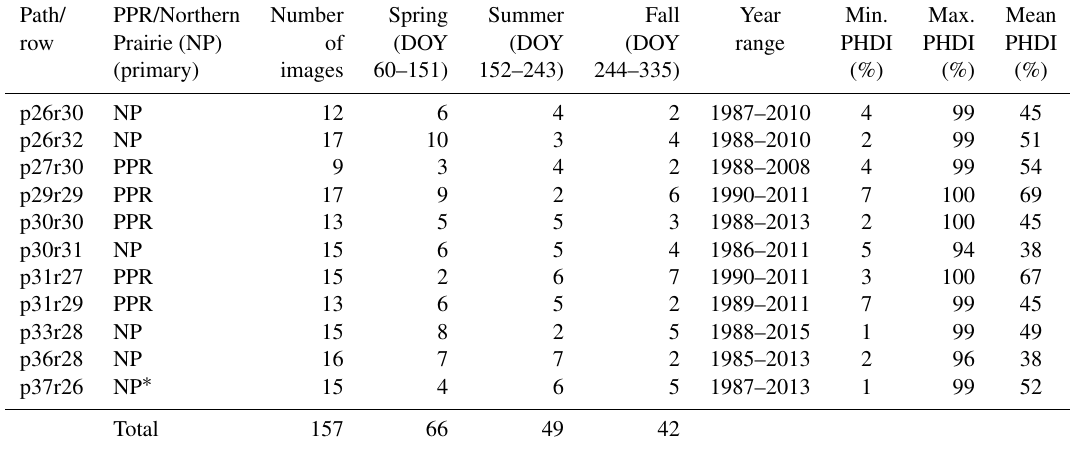
Table 1. A summary of the Landsat images utilized within each selected path/row. Landsat TM images were used for dates 2011 and earlier. Landsat 8 OLI images were used for 2013 forward. DOY – day of year; NP – Northern Prairie, PPR – Prairie Pothole Region, and PHDI – Palmer Hydrological Drought Index. ∗ p37r26 was considered NP because of its dissimilarity with the rest of the PPR.